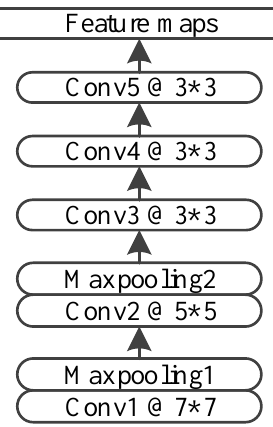
Figure 3. The convolutional neural network used to generate feature maps. (conv: number of feature maps; @: filter